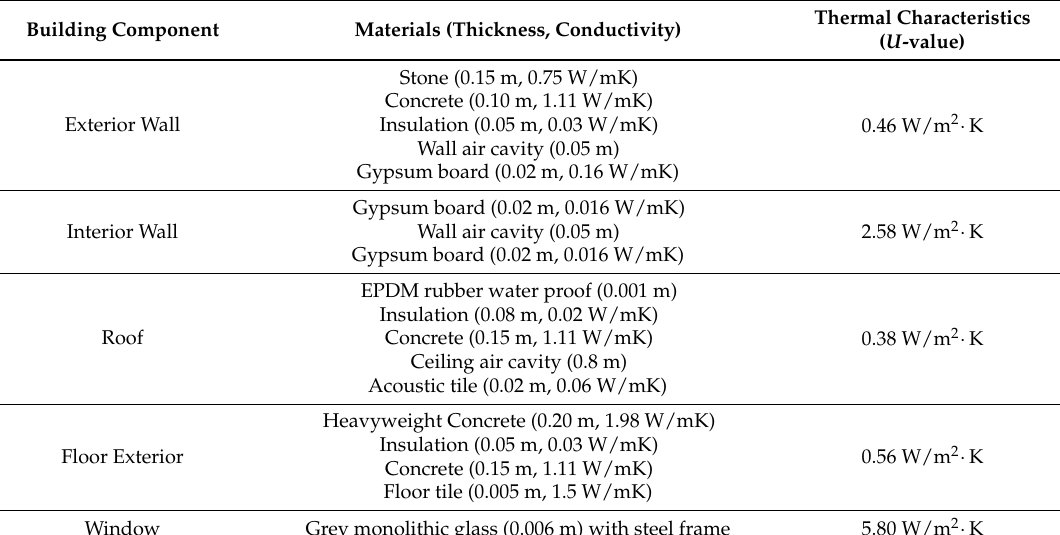
Table 1. Thermal properties of building component.